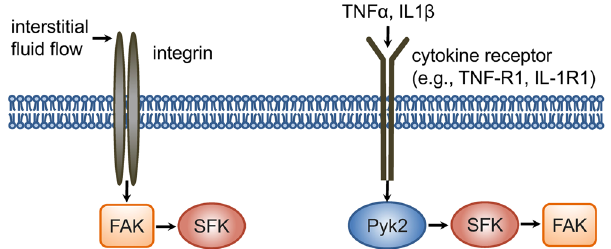
Figure 6. A proposed model of distinct molecular hierarchy of SFK and FAK in mechanotransduction and cytokine signaling. Interstitial fluid flow regulates FAK in the lipid rafts, which is mediated by integrin β 1, and subsequently regulates SFK. In contrast, TNF α and IL1 β activate SFK in the lipid rafts, which is mediated by Pyk2, and subsequently activate FAK. Through the integrin β 1-FAK-SFK signaling axis, intermediate level of fluid flow enables suppression of pro-inflammatory cytokine-induced SFK/FAK